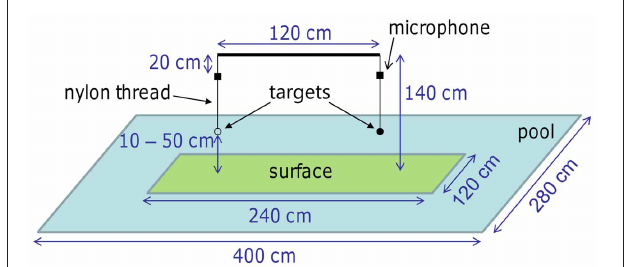
FIGURE 1 | Setup of the Field and Laboratory experiments. In the two-alternative forced-choice paradigm the bat had the opportunity to attack one of the targets (mealworm or dummy). The surface beneath the targets was covered either with artificial grass or smooth PVC, or the place was left clear for the water surface. The two targets were always presented at the same height which was 10, 20, 35, or 50cm above the surface. The horizontal bar holding the targets and microphones was attached to the ceiling of the Laboratory or, for the Field experiment, to a fishing rod anchored to the